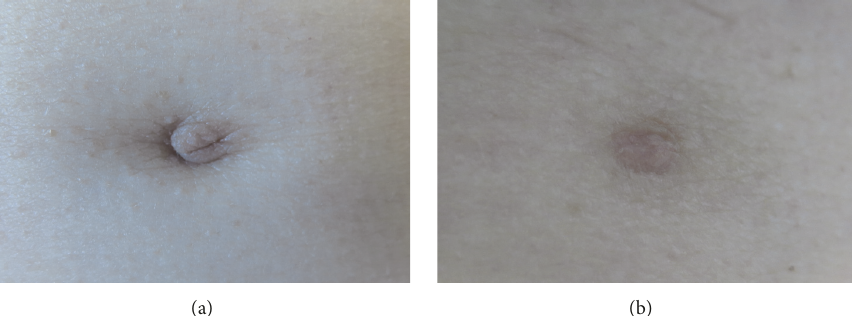
Figure 1: Clinical photo of the supernumerary nipple on the right (a) and left side (b) of the upper abdominal wall. The one on the right side (a) presents with visible inversion of the supernumerary nipple.